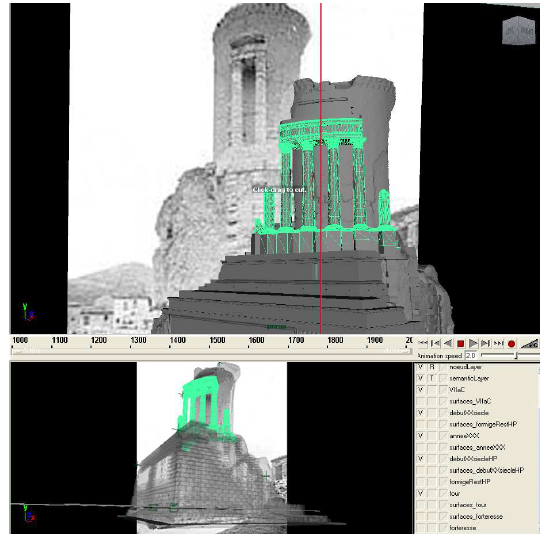
Figure 5. Modifying tool: split operation of the actual state of the colonnade according to entities visible in the previous state.